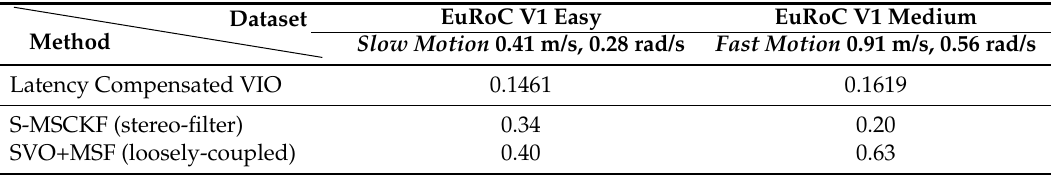
Table 4. Comparison with other methods in RMS position error [m] of latency compensated